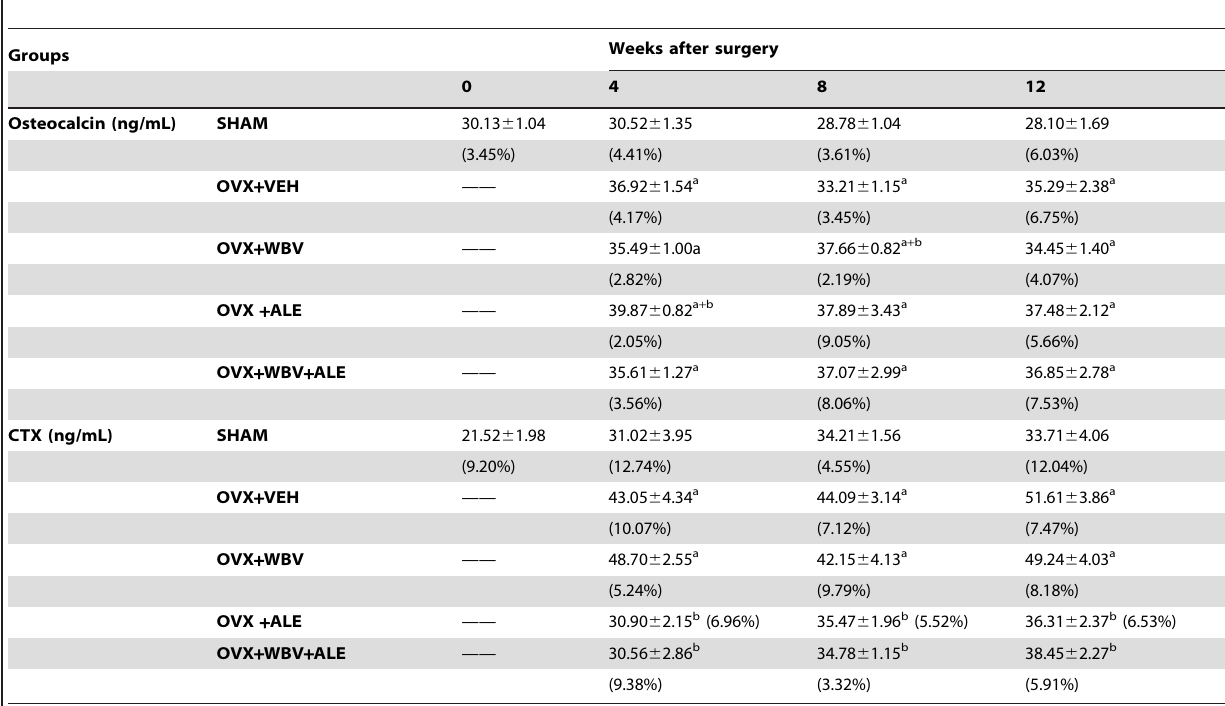
Table 1. Quantitative analysis of bone formation (osteocalcin) and resorption (CTX) markers of the serum levels in rats.